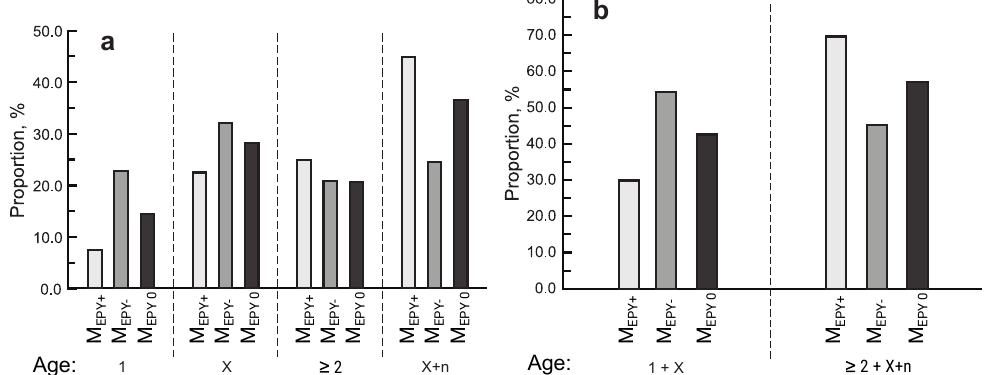
Figure 6. The age distribution (%) in males that mated with extra-pair females ( M EPY + ), those who lost their paternity ( M EPY − ) and monogamous males ( M EPY 0 ). Bars painted in different shades of grey denote groups of males for which the proportions of age classes were calculated. Age groups are labelled as yearlings (1), males aged 2 years and older ( ≥ 2), males of uncertain age first caught in the study area (X), and males recaptured in the study area (X + n, where n = 1, 2, 3, etc.) One-year-old and older individuals (age 1 and ≥ 2) were born in the research area and were ringed as nestlings in previous reproductive seasons. Males of unknown age (X and X + n) were ringed as adult